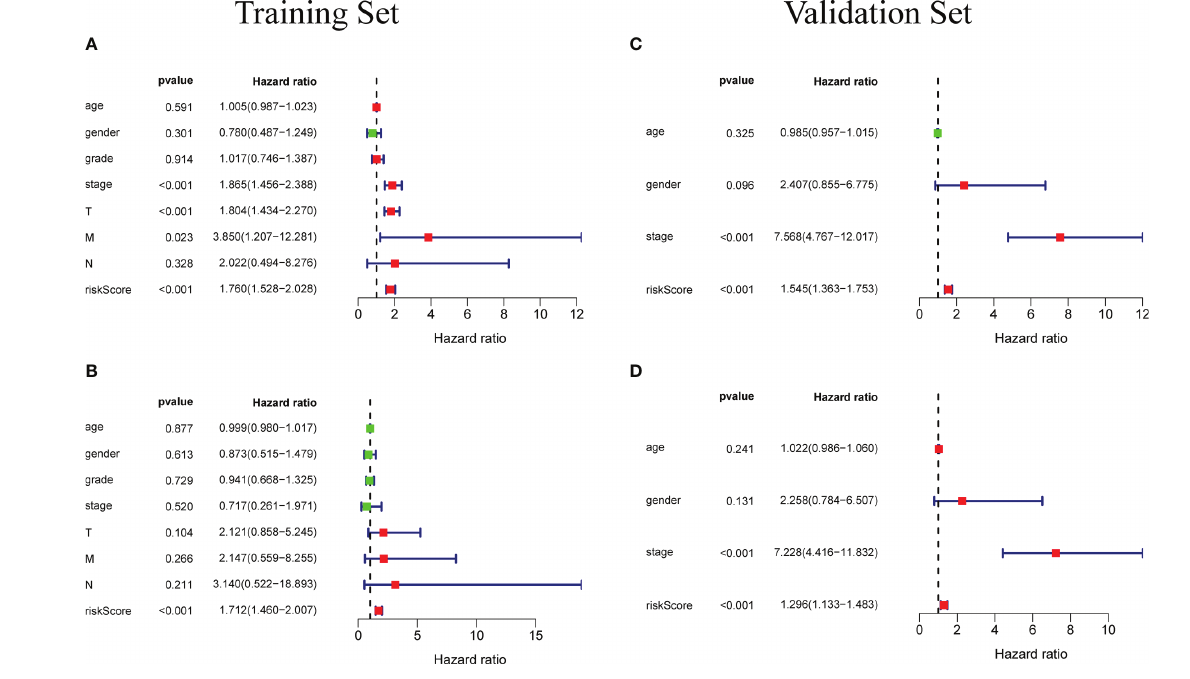
Frontiers in Oncology |